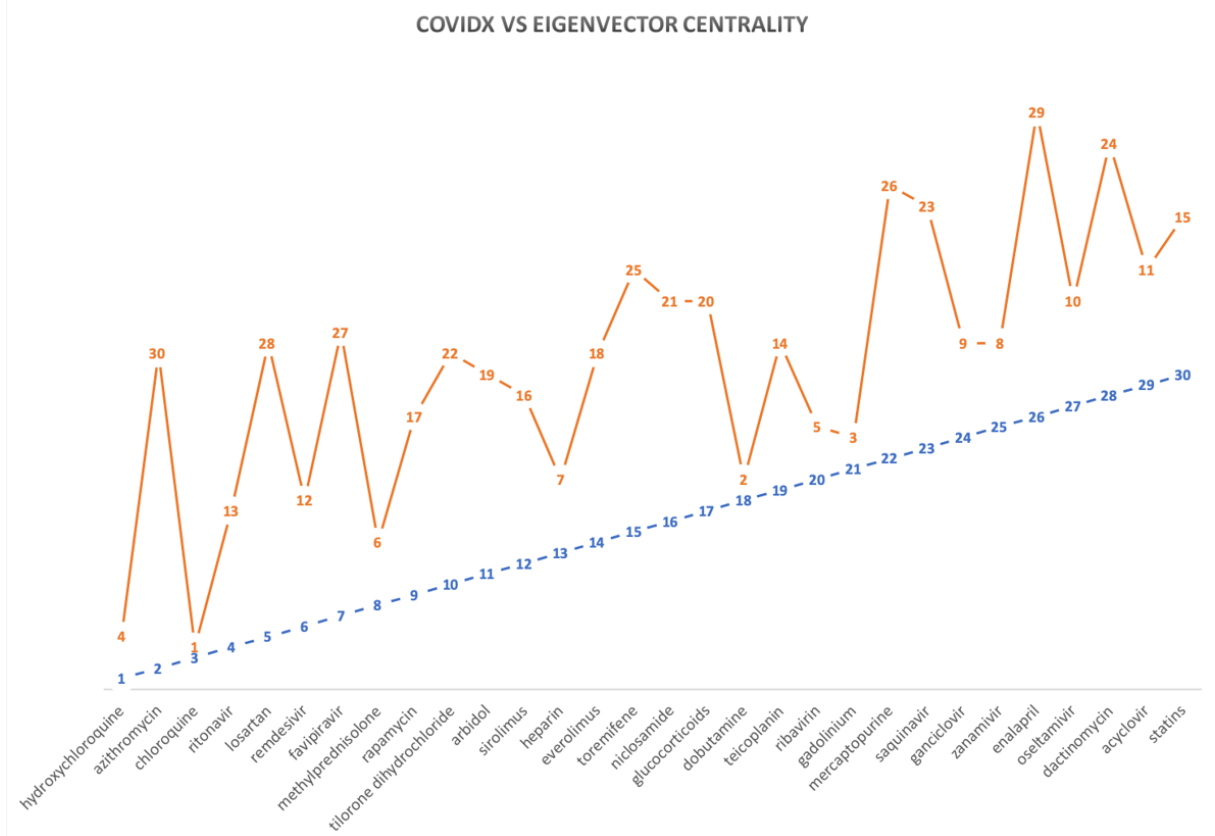
Figure 6. A comparison of the ranks computed by the CovidX algorithm vs the eigenvector centrality of each drug. The horizontal axis is the drugs listed in alphabetical order, and the vertical axis shows the